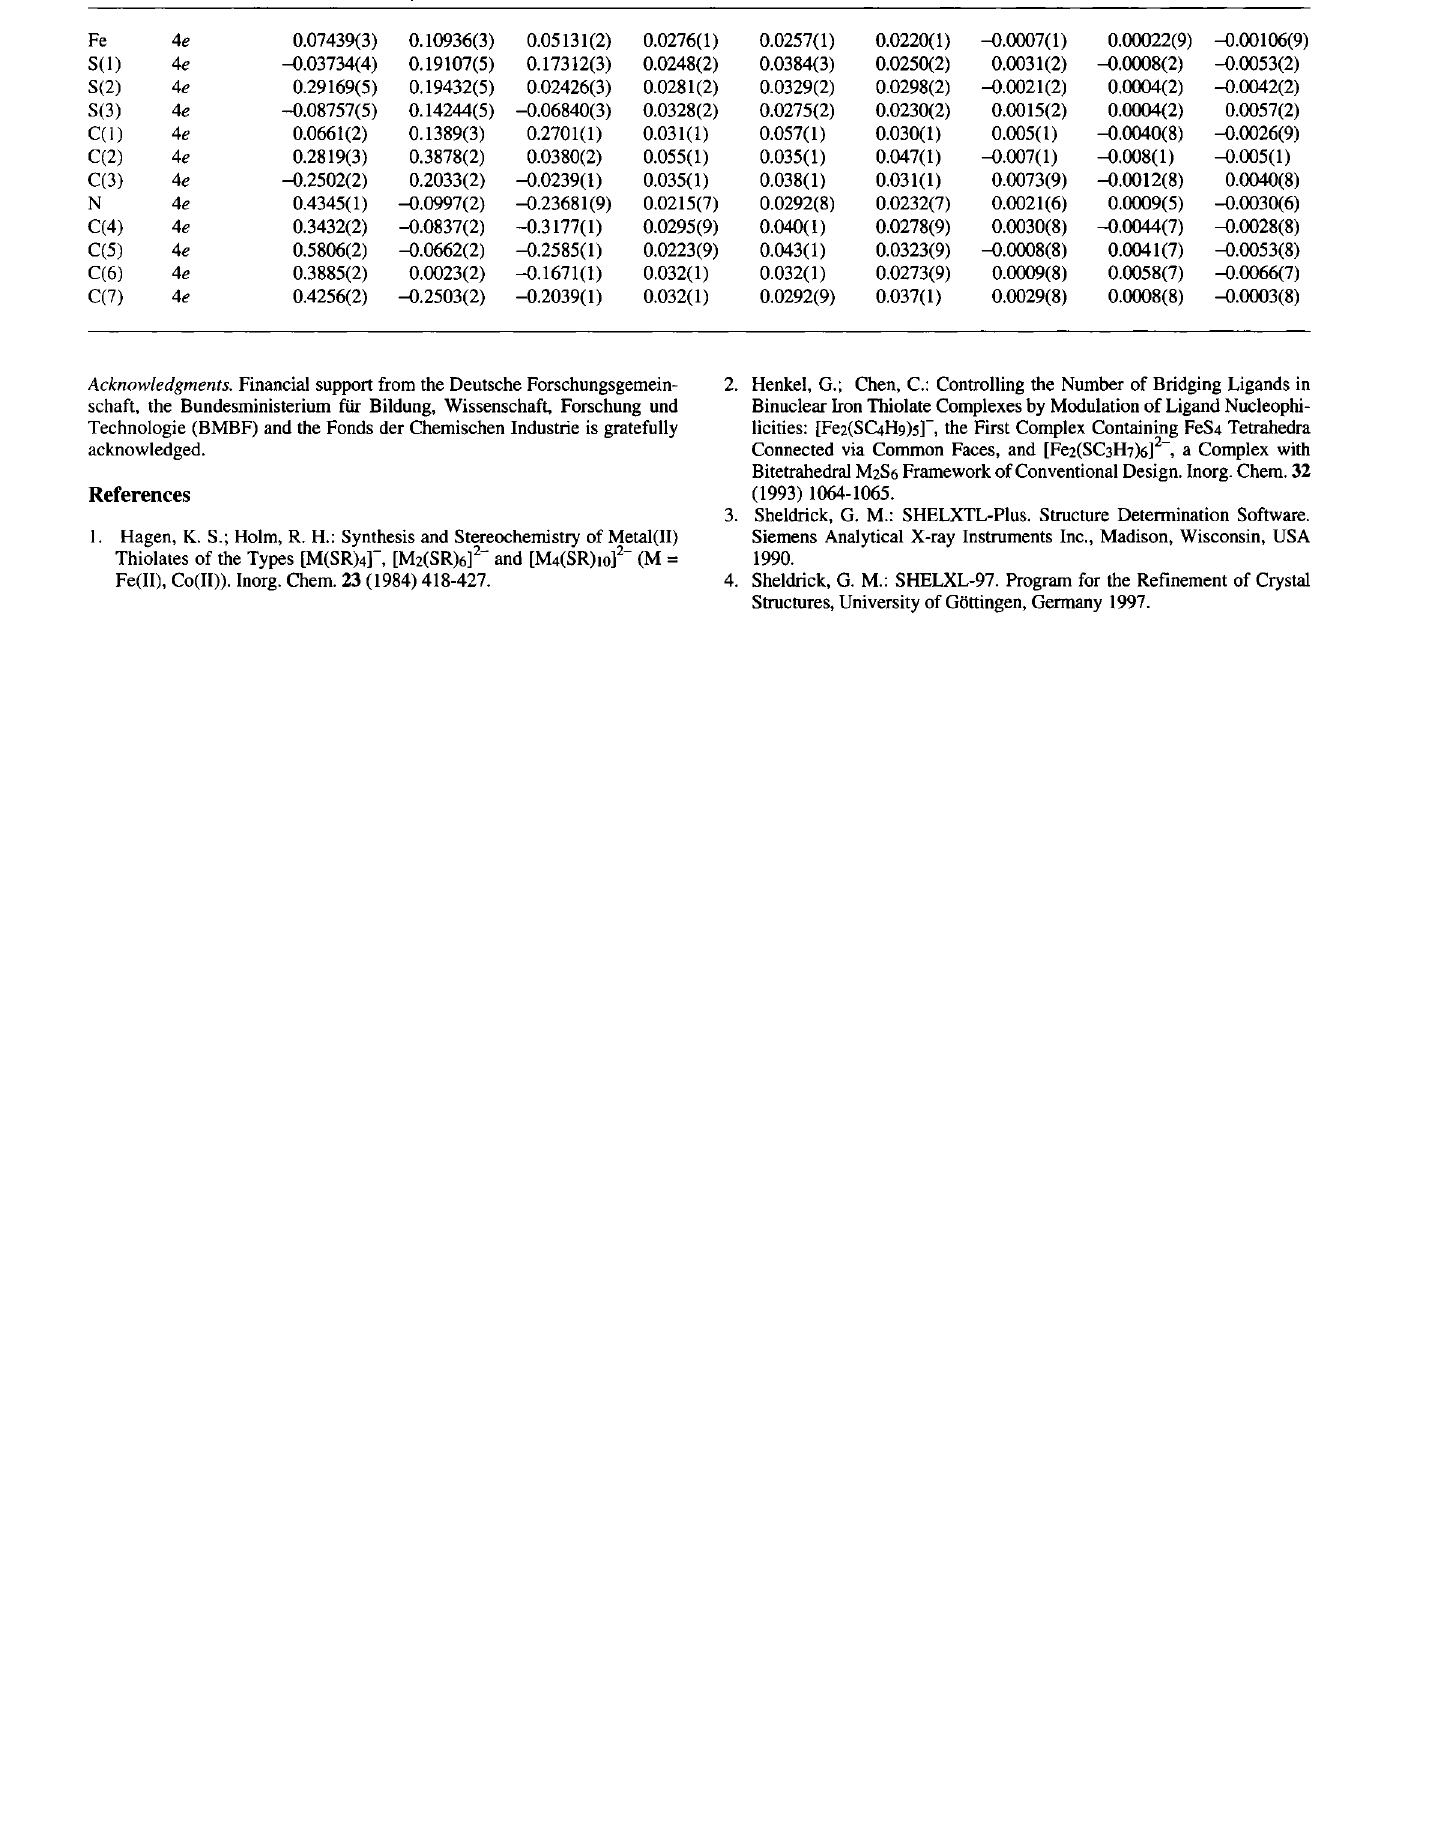
Table 3. Atomic coordinates and displacement parameters (Â 2